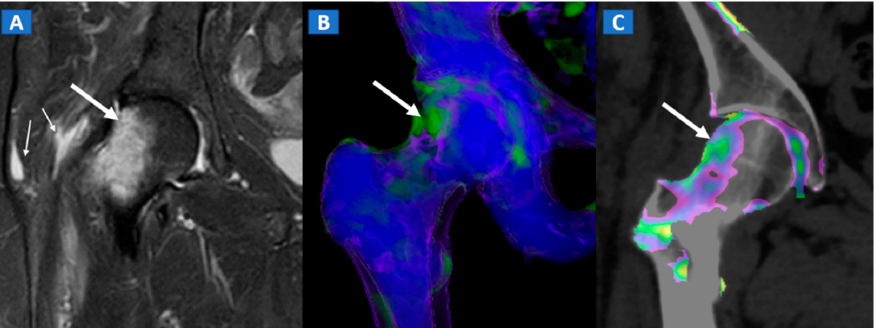
Figure 6. A 46-year-old female with non-traumatic right hip pain. On the coronal STIR MRI image ( A ), hyperintense BME of the femoral neck is depicted (thick arrow), sparing the subchondral femoral head area. Note the associated trochanteric bursitis (thin arrows). The pattern of distribution of BME (arrow) is confirmed on the corresponding DECT coronal 3D image ( B ), and on the 1 mm coronal DECT image ( C ) (arrow).